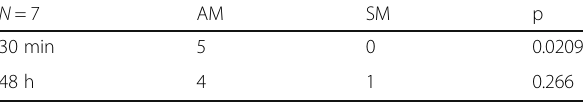
Table 2 Number of responding patients at 30 min and 48